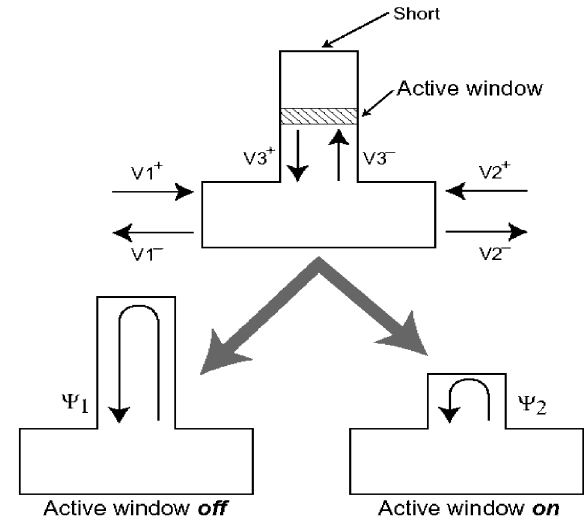
FIG. 2. (Color) Operating principle of SPST array.